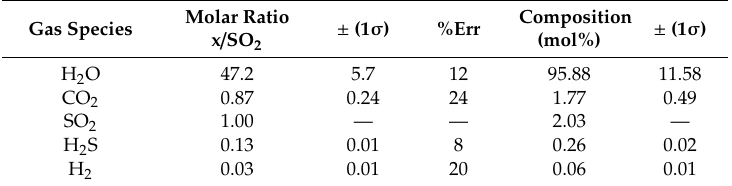
Figure 3. x/SO 2 Mixing ratios in the Mount Garet plume. ( A ): scatterplot of dot-to-dot x/SO 2 molar ratios versus SO 2 concentrations, showing that the ratios converge to a single value at high SO 2 concentration (Tamburello, 2015); and concentration (ppmv) time series of each species (CO 2 in red, H 2 S in green, H 2 in orange and H 2 O in blue) with SO 2 (in black) in the Mount Garet plume (note that the x -axis gives the duration of the each survey in seconds). ( B ): Least-square regression analysis are shown for each species versus SO 2 ; Slope and R 2 regression values in black correspond to the specific time window shown in A; colored values correspond to the regression analysis of bulk data reported in Table 1. Table 2. Bulk composition of Mount Garet’s plume; x / SO 2 ratios correspond to the gradients of the best-fit regression lines of all combined ratios reported in Table 1 for a given x / SO 2 pair. Errors are expressed as the standard error of the regression analysis and subsequent error